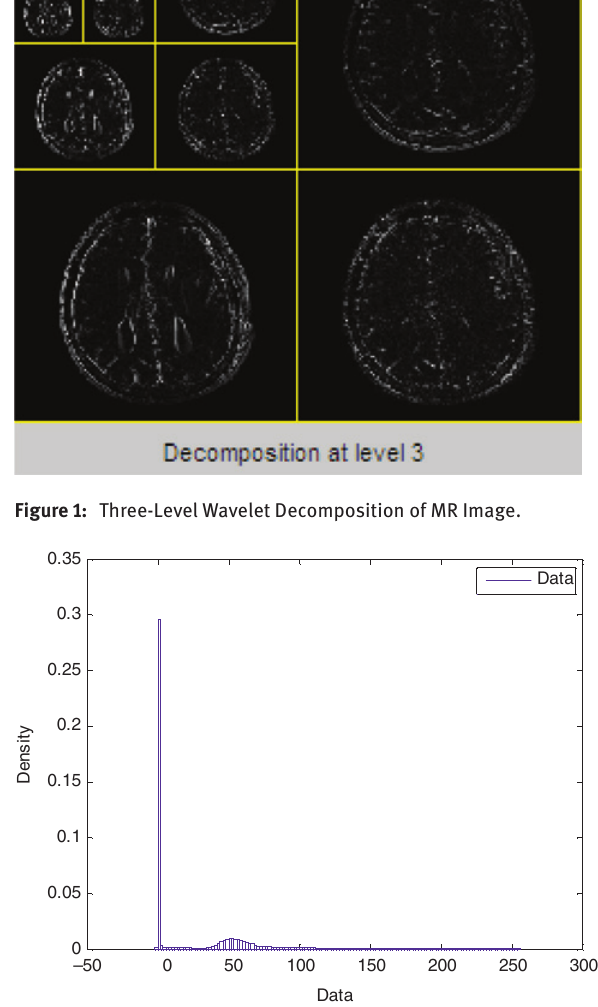
Figure 2: Distribution of Wavelet Coefficients.